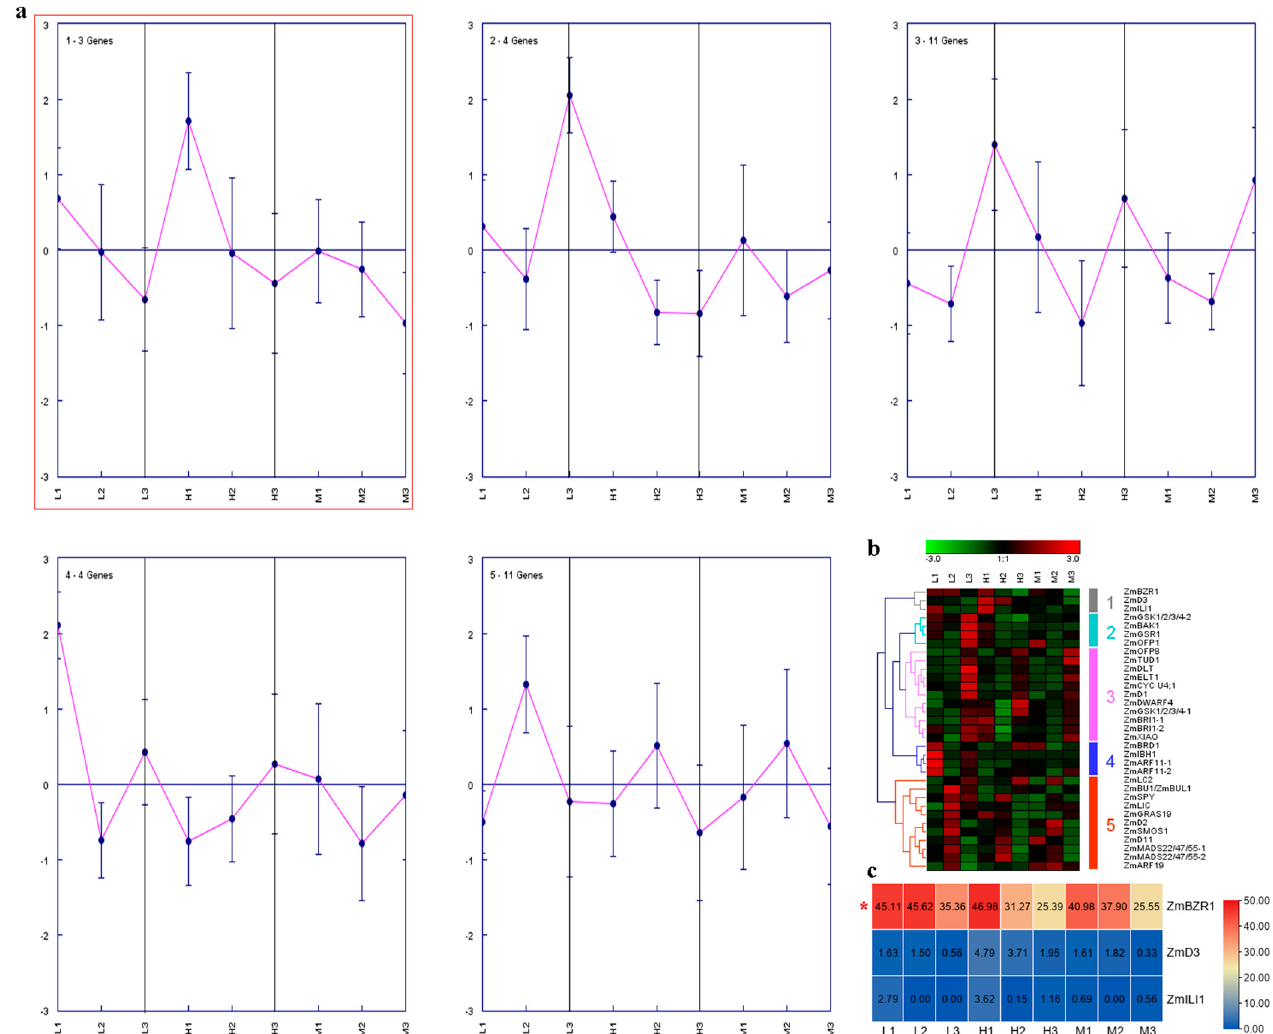
Figure 3. Trend analysis of BR-related genes in three different maize hybrids with distinct plant heights. ( a ) Clusters were obtained based on expression data of BR-related genes in three different maize hybrids at the jointing stage (1), big flare period (2), and tasseling stage (3). ( b ) Heatmap of all clusters. ( c ) Expression levels of other BR-related genes in three different maize hybrids at three stages. Genes with high expression are marked with a red asterisk.